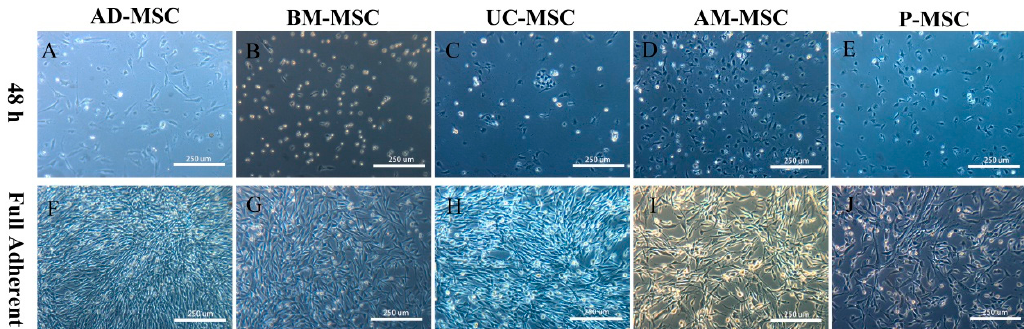
Figure 1. Adherence and primary growth of five types of mesenchymal stem cells (MSCs) from different sources (100 × ): adipose mesenchymal stem cells (AD-MSCs), placenta mesenchymal stem cells (P-MSCs), bone marrow mesenchymal stem cells (BM-MSCs), umbilical cord mesenchymal stem cells (UC-MSCs), and amniotic mesenchymal stem cells (AM-MSCs). Morphology of mesenchymal stem cells in primary culture for 48 h (Figure A – E ). Status of mesenchymal stem cells in primary